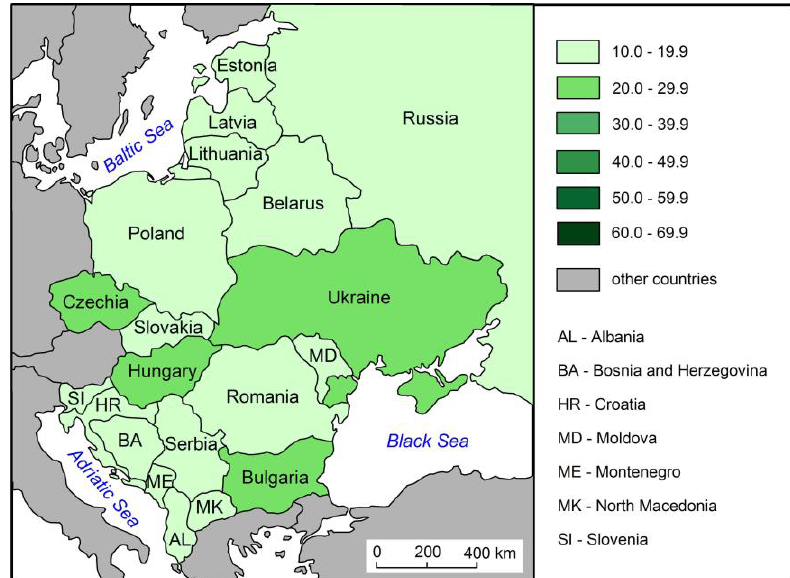
Fig. 2. Old-age dependency ratio in 1990 (Source: United Nations,